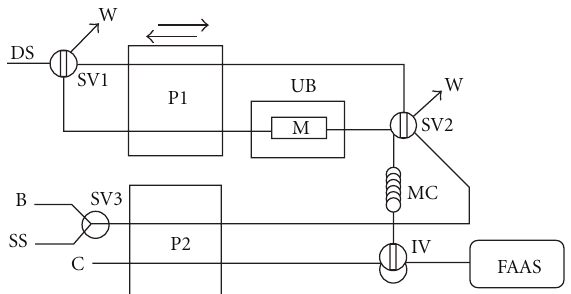
Figure 1: Experimental setup used for the continuous ultrasound- assisted dissolution step and FI determination of iron, manganese, and zinc in soluble samples. P1 and P2, peristaltic pumps; DS, dissolving solution; W, waste; UB, ultrasonic bath; M, minicolumn containing the sample (dissolution cell); SS, standard solution; B, blank; IV, injection valve; SV1–SV3, switching valves; MC, mixing coil; C, carrier (ultrapure water); FAAS, flame atomic absorption